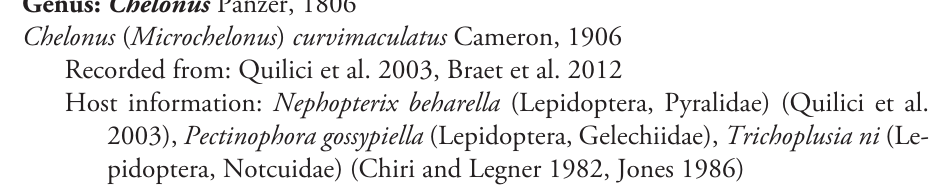
Chelonus ( Chelonus ) mayi Braet & Rousse, 2012